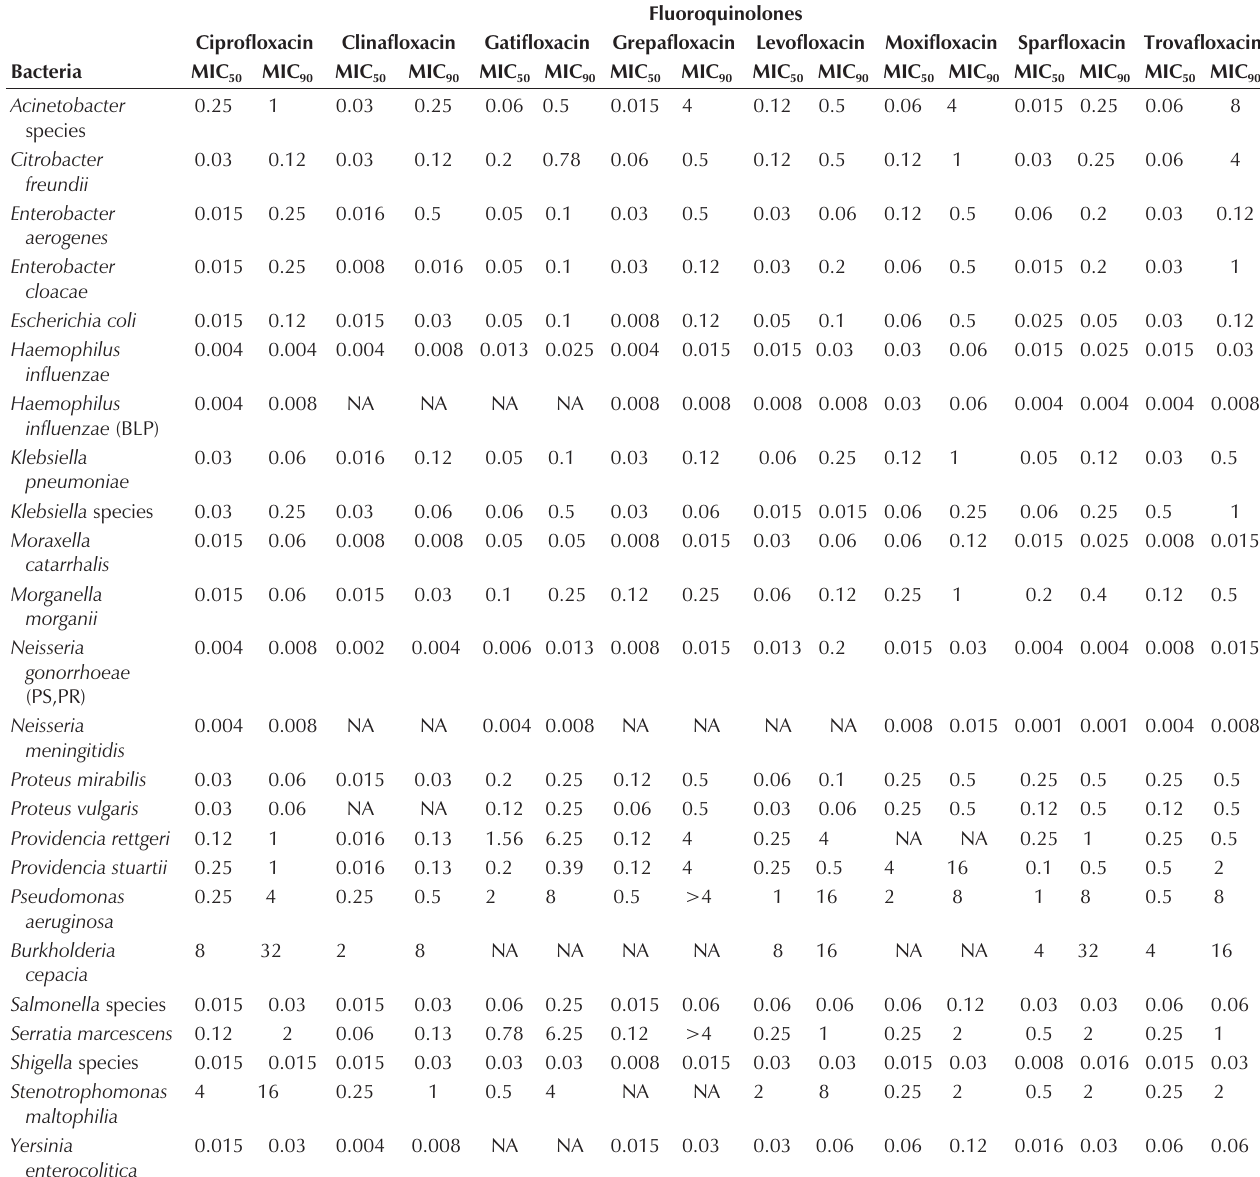
In vitro activity of the new fluoroquinolones against Gram-negative